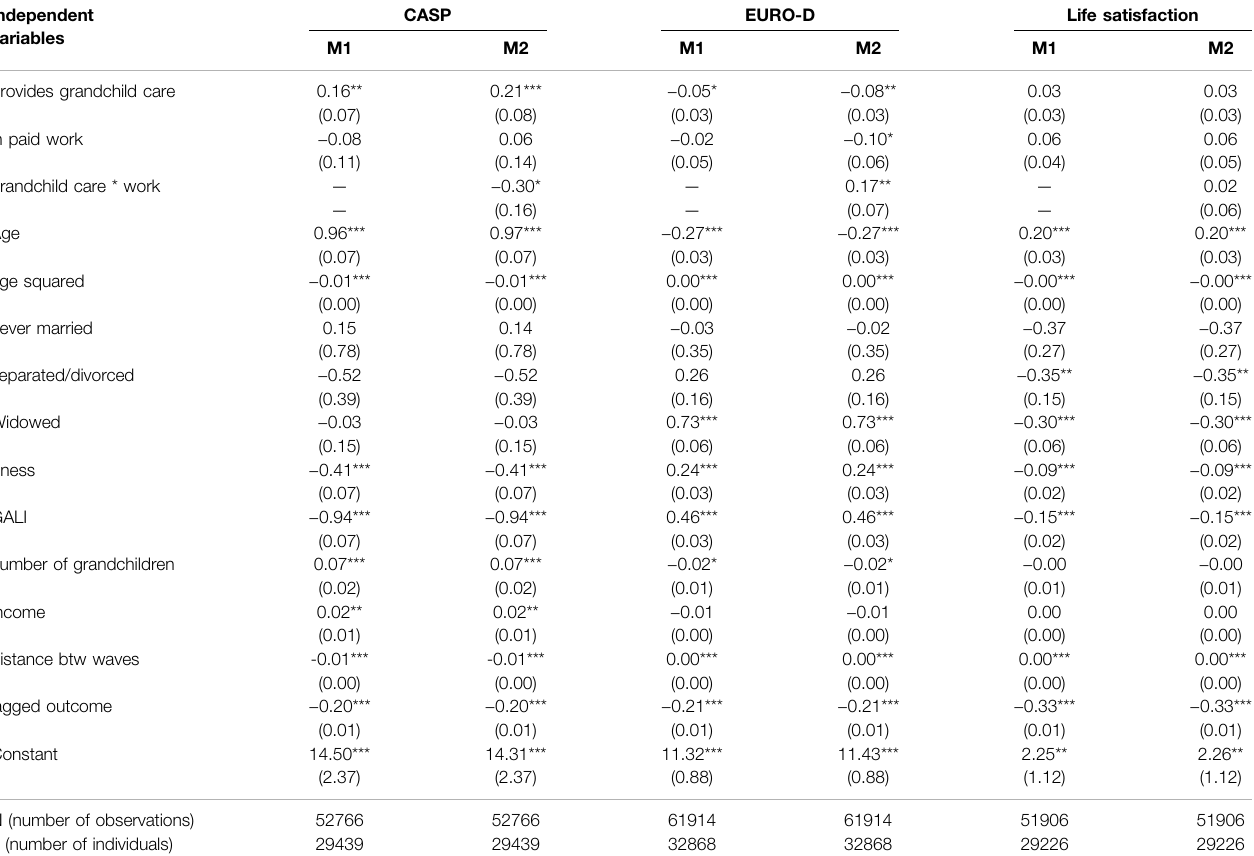
TABLE 2 | Estimated regression coef fi cients from fi xed effects dynamic models for three measures of psychological wellbeing. Independent